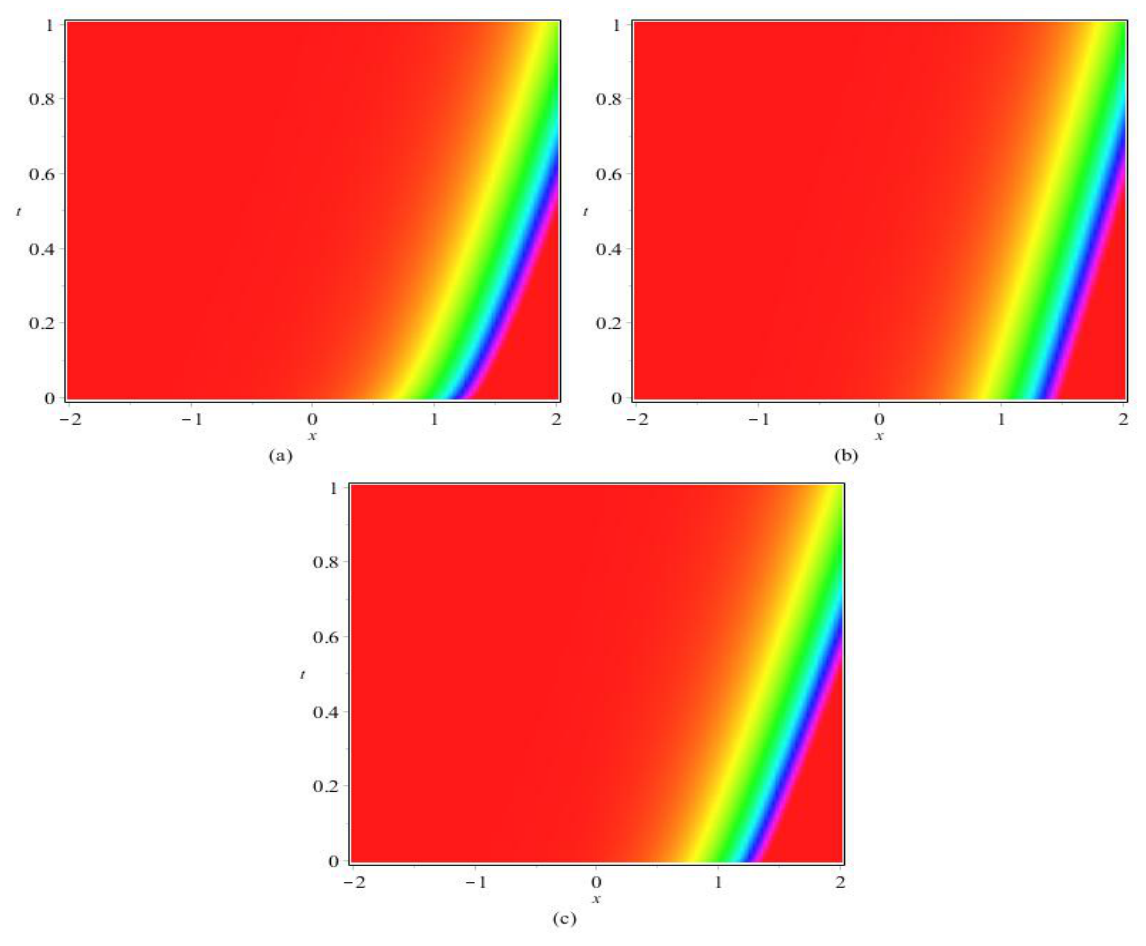
Figure 7. Exact solutions with k 1 = α 1 = a = c = 2, λ 3 = 1, and ( a ) n = 0.5, m = 2, α = 0.8, β = 0.9, w.r.t. M-derivative (22), ( b ) n = 0.5, m = 2, β = 0.9, w.r.t. beta-derivative (23), ( c ) n = 0.5, m = 2, α = 0.8, w.r.t. hyperbolic-derivative